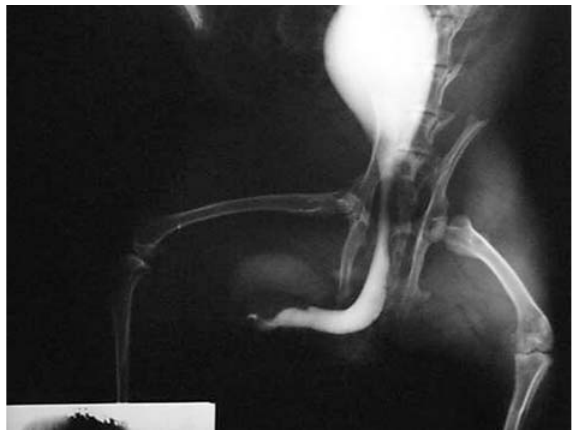
Figure 5 – Retrograde urethrogram six weeks after surgery (cid:70)(cid:82)(cid:81)(cid:191)(cid:85)(cid:80)(cid:72)(cid:71)(cid:3)(cid:87)(cid:75)(cid:72)(cid:3)(cid:80)(cid:68)(cid:76)(cid:81)(cid:87)(cid:72)(cid:81)(cid:68)(cid:81)(cid:70)(cid:72)(cid:3)(cid:82)(cid:73)(cid:3)(cid:68)(cid:3)(cid:90)(cid:76)(cid:71)(cid:72)(cid:3)(cid:88)(cid:85)(cid:72)(cid:87)(cid:75)(cid:85)(cid:68)(cid:79)(cid:3)(cid:70)(cid:68)(cid:79)(cid:76)(cid:69)(cid:72)(cid:85)(cid:3)(cid:90)(cid:76)(cid:87)(cid:75)(cid:82)(cid:88)(cid:87)(cid:3) any signs of stricture or